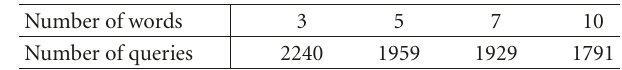
Table 9: Number of test